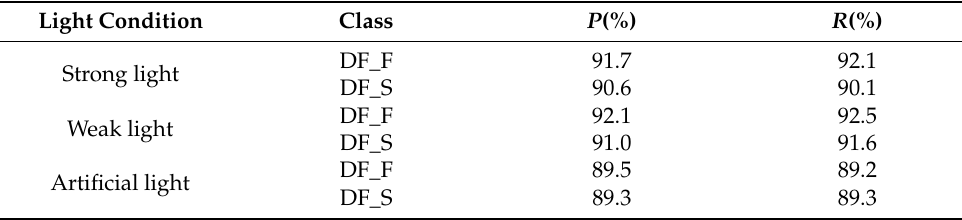
Table 8. The detection results of RDE-YOLOv7 under different light